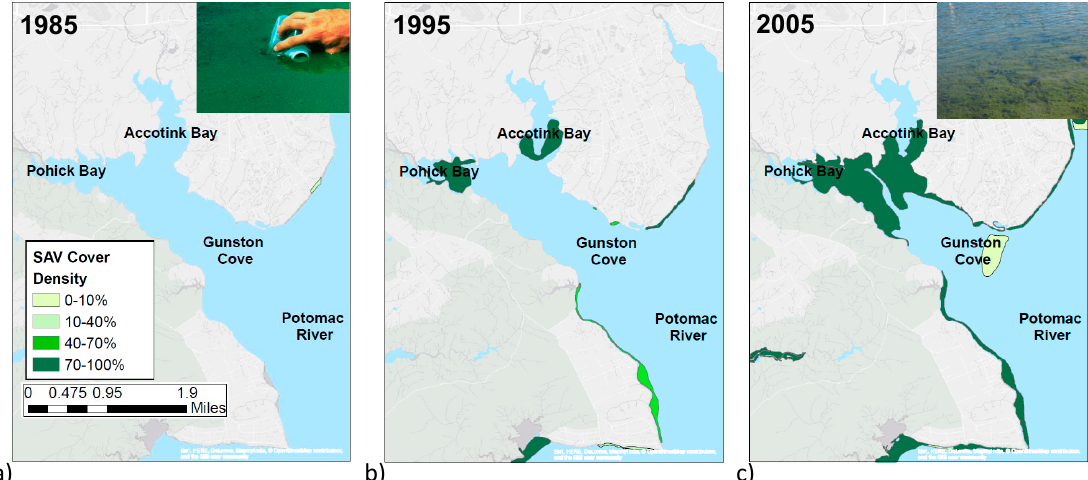
Figure 2. SAV coverage in Gunston Cove in years ( a ) 1984, ( b ) 1995, and ( c ) 2008 as representatives for the three time periods of 1984–1992, 1993–2004, and 2005–2011, respectively (data source: http://web.vims.edu/bio/sav/gis_data.html). The inset photographs are both taken in Gunston Cove, and are from an algal bloom in 1983 in the upper right corner of image ( a ), and the SAV growth in 2012 in the upper right corner of image (c).